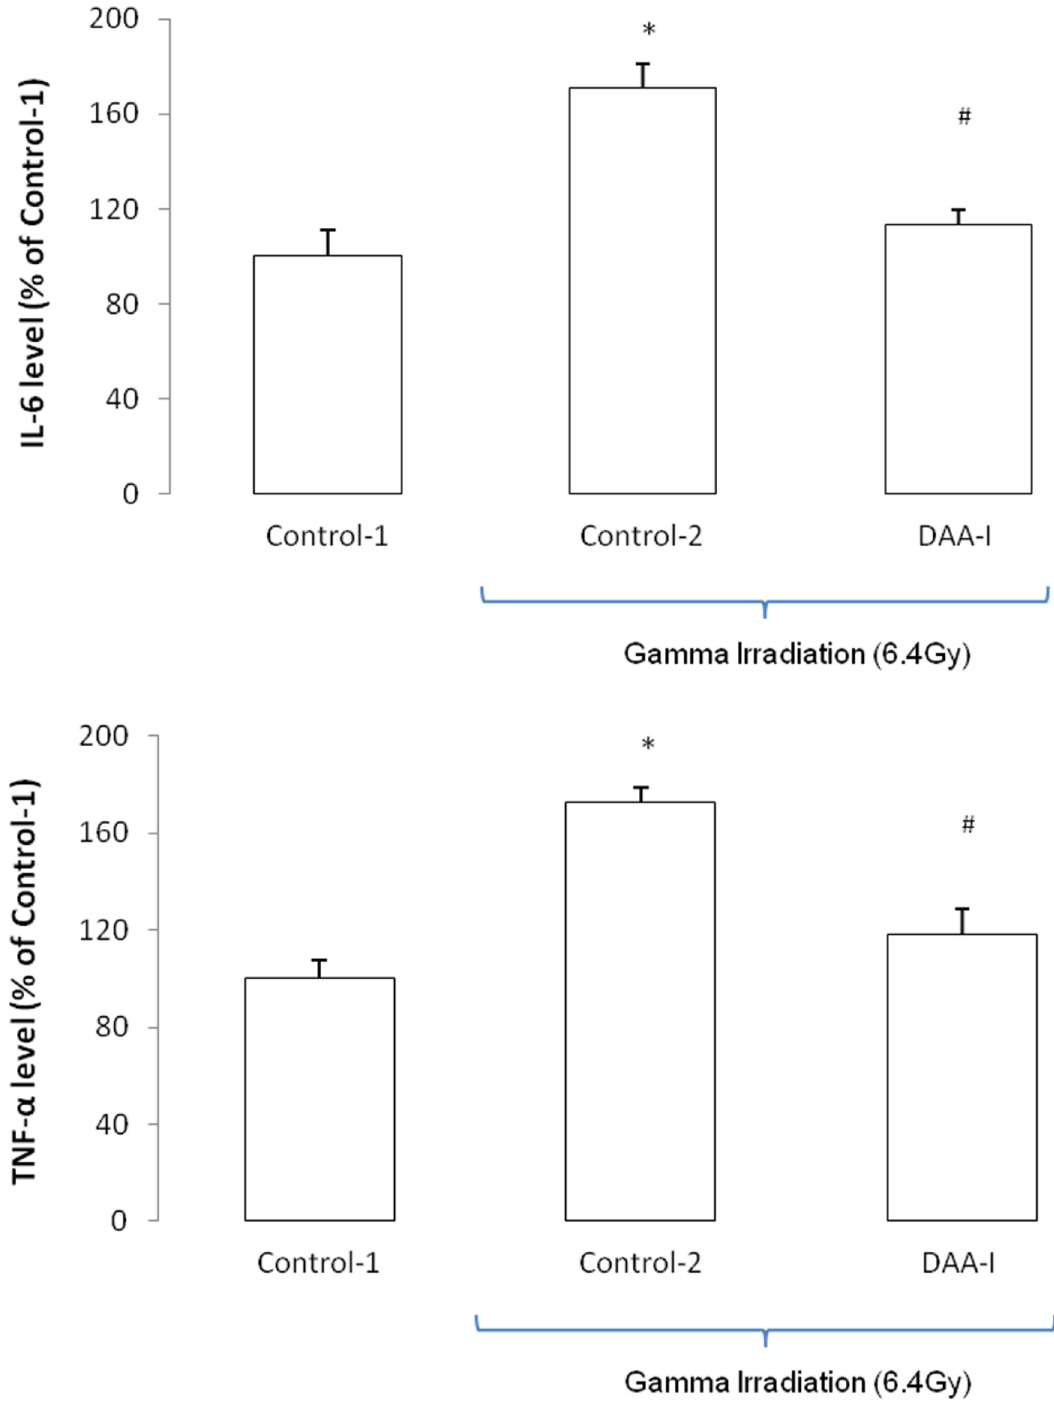
Fig 3. Effects of DAA-I on expression of IL-6 andTNF- α in plasma of gamma irradiated mice.. Control-1: animals were administered 0.1 ml vehicle (water) and were not irradiated. Control-2: animals were administered vehicle and were irradiated. DAA-I: animals were administered 800 nmole/kg DAA-I and were irradiated. Each value was a mean ± S.E.M. obtained from 3 separate animals. Comparison between groups was analyzed by One-Way ANOVA followed by Tukey ’ s post-hoc test. * p < 0.05 vs Control-1. # p < 0.05 vs Control-2.